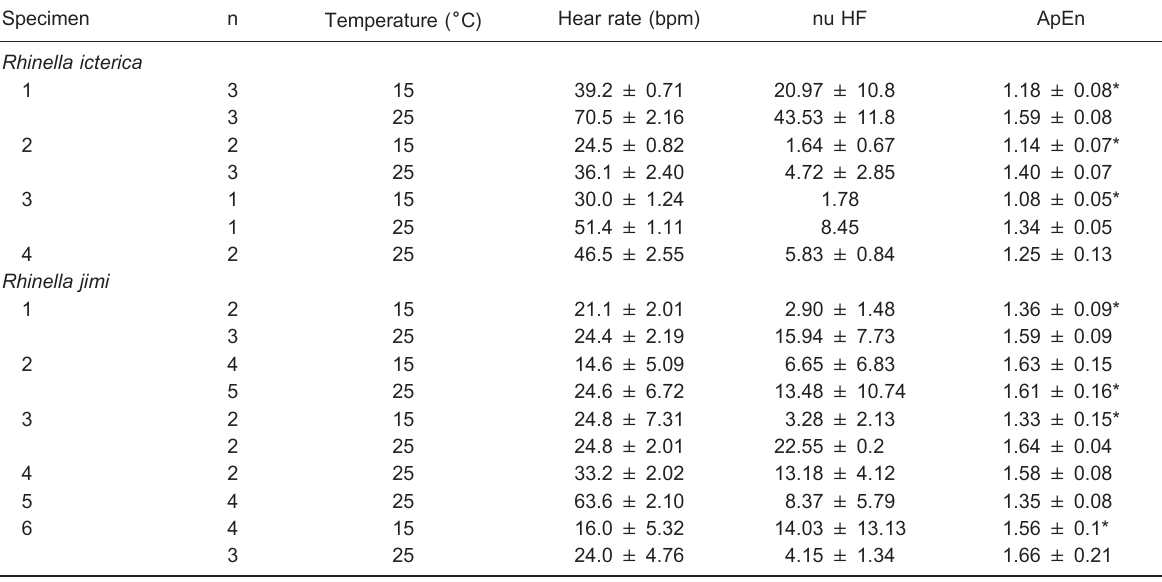
Table 1. Heart rate, ApEn, and nu HF obtained for the number (n) of segments for 4 Rhinella jimi and 6 Rhinella icterica at 15 6 and 25 6 C. Specimen n Temperature ( 6 C) Hear rate